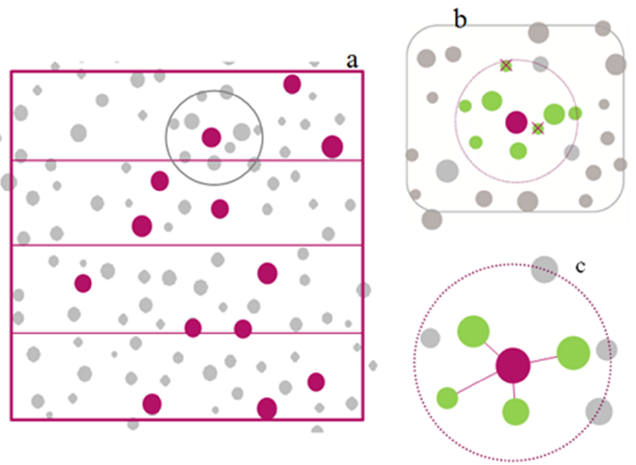
Figure 3. Schematic diagram of the “randomized management of medium- and large-diameter trees” method: ( a ) several medium- and large-diameter trees selected from the management forest stand are represented by red circles; ( b ) the 8 nearest neighbors of a medium- and large-diameter tree. Two trees need to be cut down due to unhealthy status, and they are represented by the × symbol. The green circle represents trees that may be temporarily reserved as neighbors. ( c ) After cutting unhealthy trees, four large trees that can form random structure units were selected, which are represented by green circles, while the other gray trees were not treated.